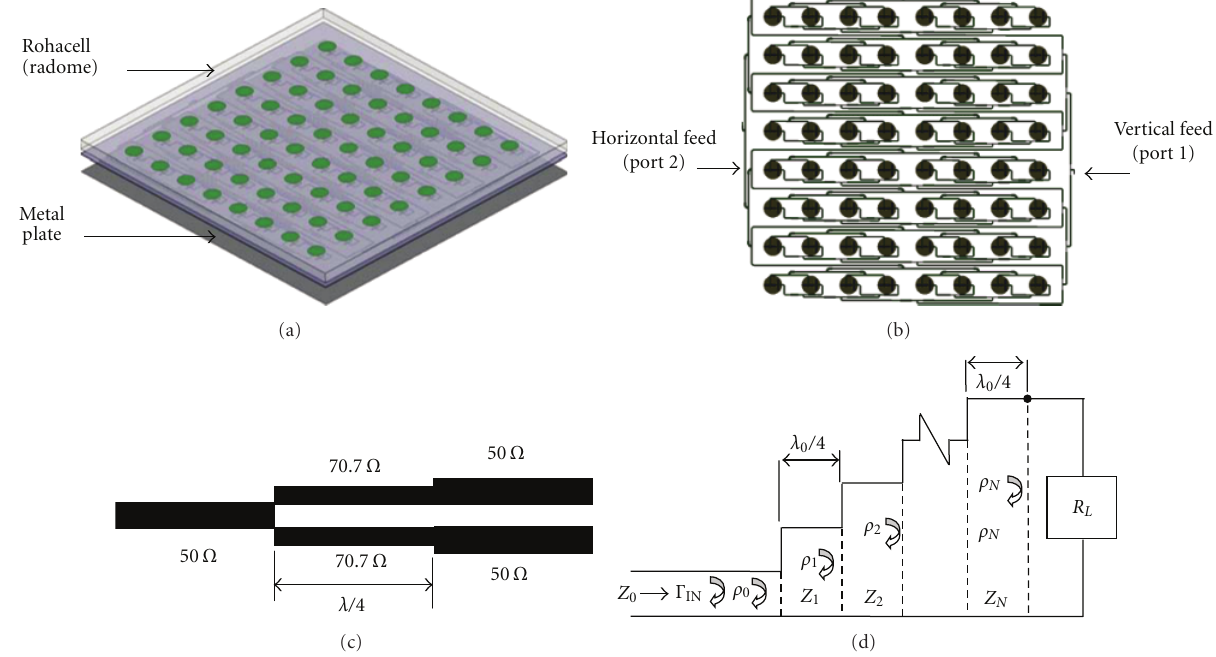
Figure 2: (a) 3D view of 8 × 8 array antenna with its ground plane. Rohacell (bottom: circular patches): ε r = 1 . 06, h r = 12mm; substrate (top: slots, bottom: feed lines): ε rf = 4 . 5, h f = 0 . 762 mm. (b) Feed structure of array antenna. (c) Quarter-wave matching transformer. (d) N -section λ/ 4